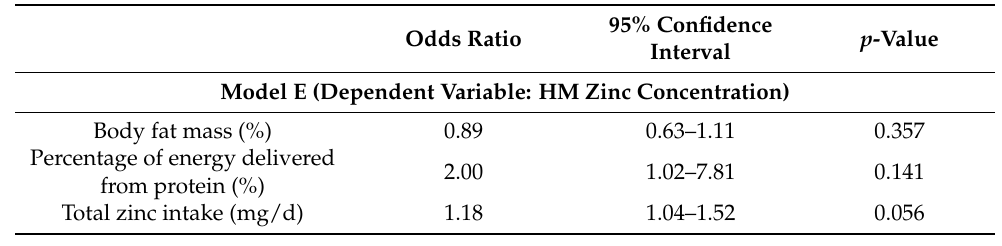
Table 8. Results of multivariable logistic regression analysis for the prediction of HM zinc concentra- tion higher than 90th percentile 1